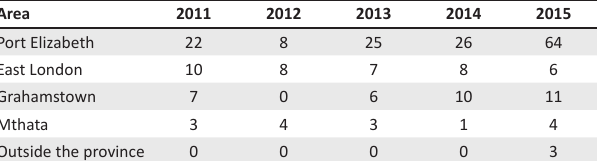
TABLE 3: Number of admissions to Tower Psychiatric Hospital and Psychosocial Rehabilitation Centre for the years 2011–2015. Area